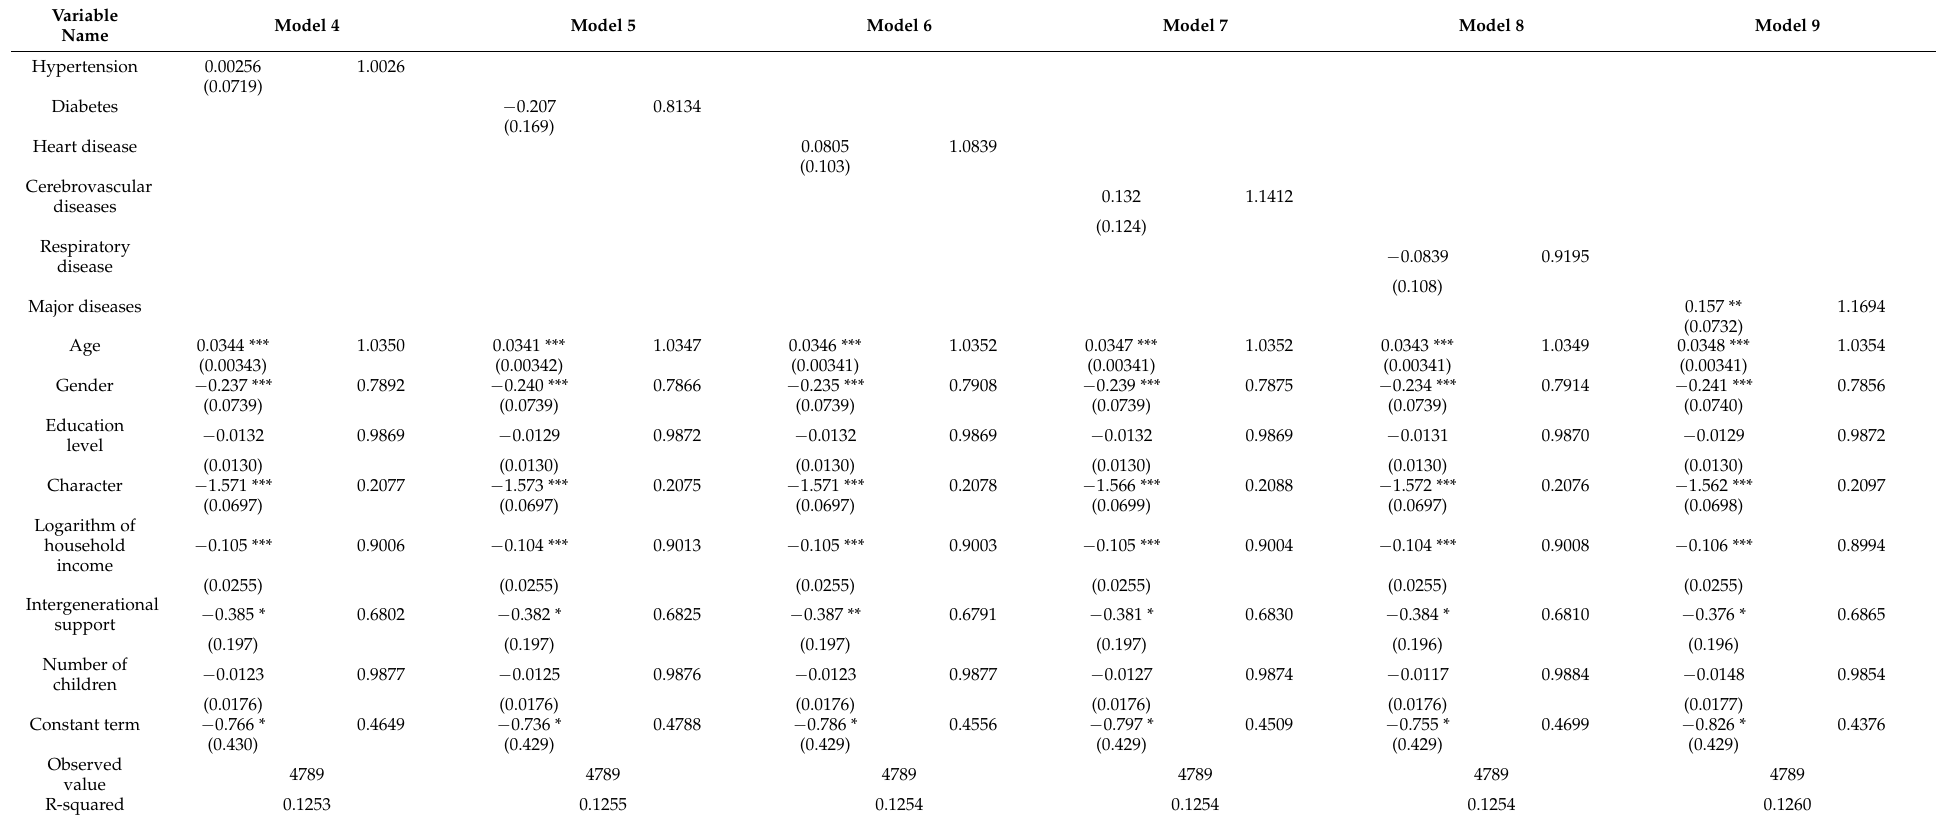
Table 5. Model estimation results of health status on loneliness of rural